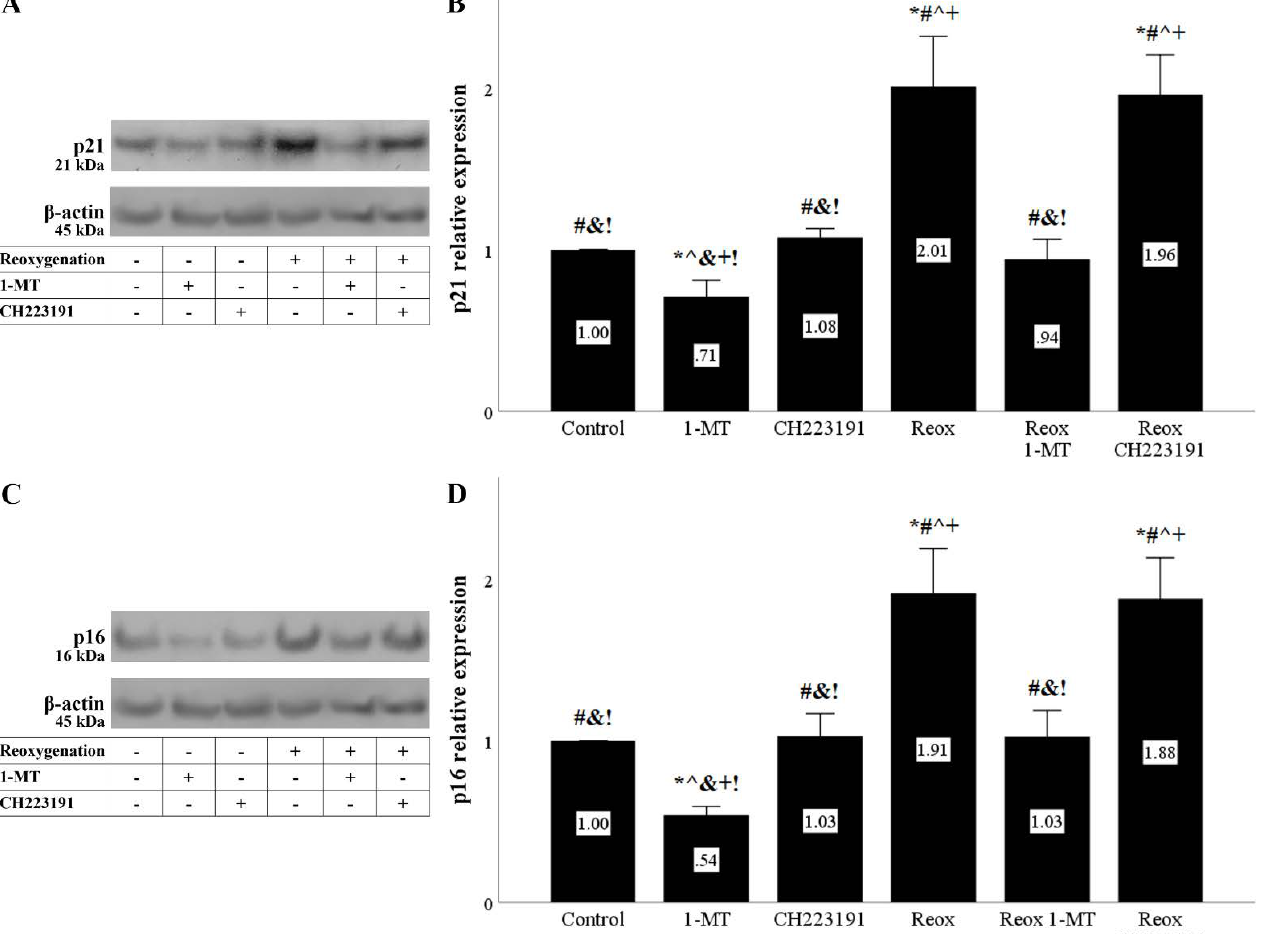
Figure 8. Reoxygenation upregulates the cell-cycle inhibitors p21 and p16, whereas inhibition of IDO prevents their upregulation. Cells were cultured under anoxic conditions for 24 h and then subjected to 2 h of reoxygenation along with the indicating treatments. Reoxygenation increased p21 levels. 1-MT, but not CH223191, prevented p21 increase. A representative Western blot experiment is displayed in panel (A), whereas panel (B) depicts the cumulative results of four repeated experiments. Reoxygenation upregulated p16 levels. 1-MT, but not CH223191, prevented p16 upregulation. A representative Western blot experiment is displayed in panel (C), whereas panel (D) depicts the cumulative results of four repeated experiments. * p < 0.05 vs. Control, # p < 0.05 vs. Control with 1-MT, ^ p < 0.05 vs. Control with CH223191, & p < 0.05 vs. Reox, + p < 0.05 vs. Reox with 1-MT, ! p < 0.05 vs. Reox with CH223191. Error bars correspond to SEM. 1-MT, 1-DL-methyltryptophan; Reox, reoxygenation.